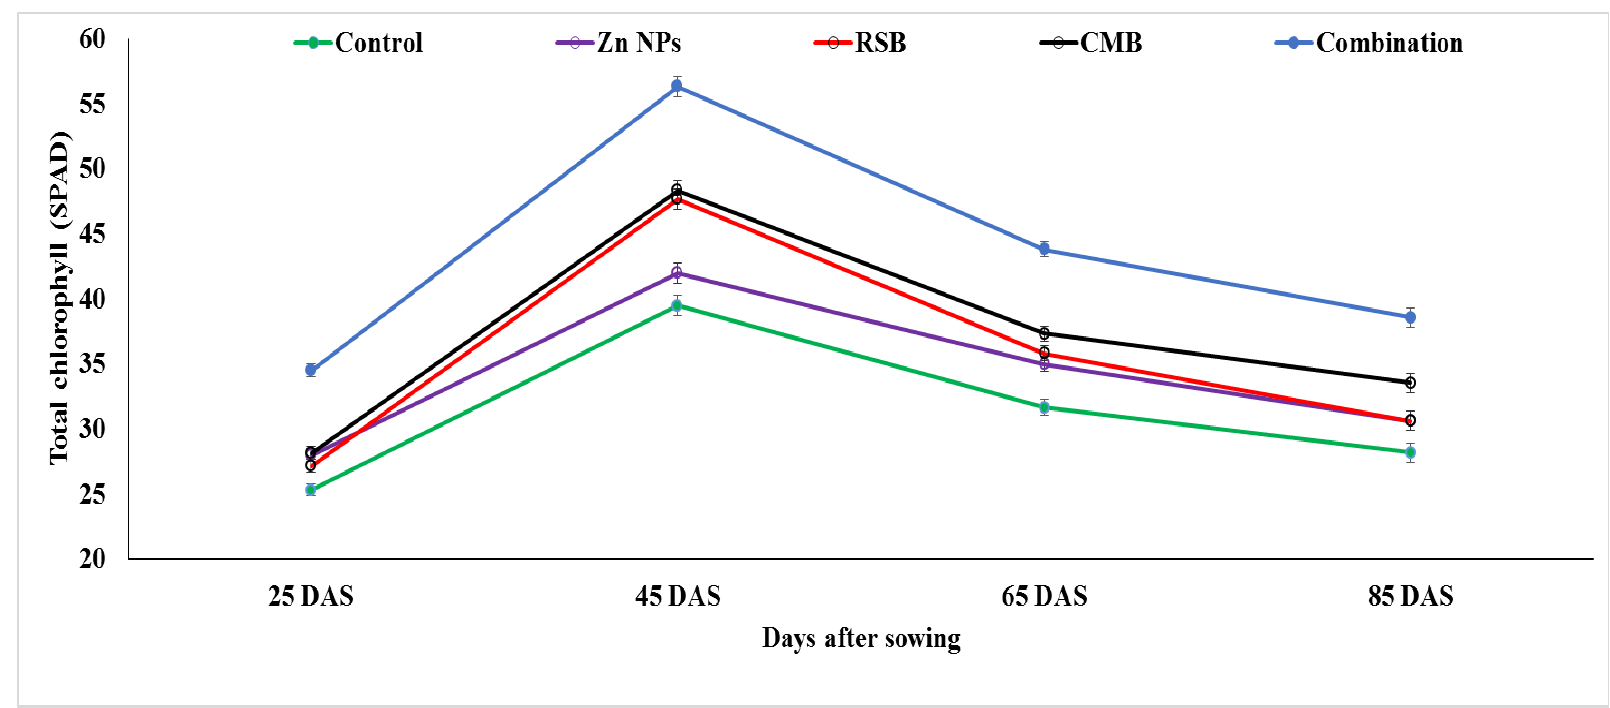
Figure 3. Effect of zinc nanoparticles, and biochar of rice-straw and cow-manure on total chlorophyll content (SPAD) of sunflowers grown in soil irrigated with wastewater for long-term (Data are the combined statistical analysis over the two seasons). Zn NPs = Zinc nano-particles, RSB = Rice straw biochar, CMB = Cow manure biochar, Bars = Standard error of means (SEM), DAS = Days after sowing.